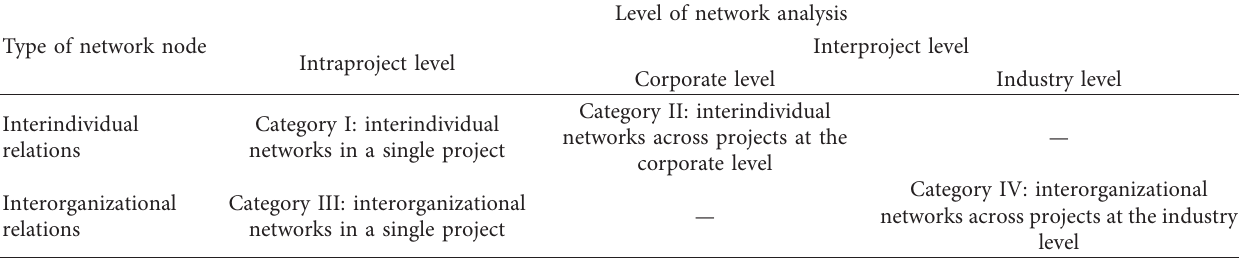
Table 3: A categorization framework of network research in